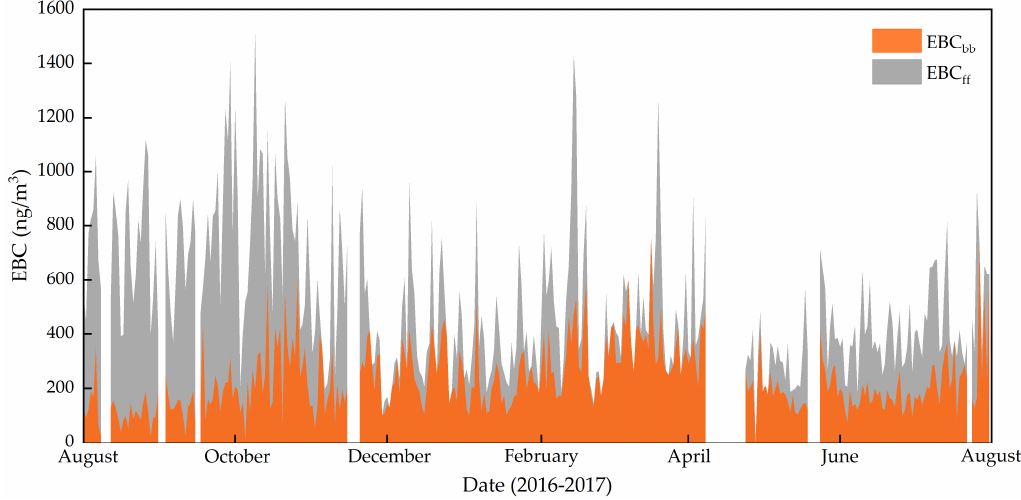
Figure 7. The daily mean concentrations of EBC ff and EBC bb.